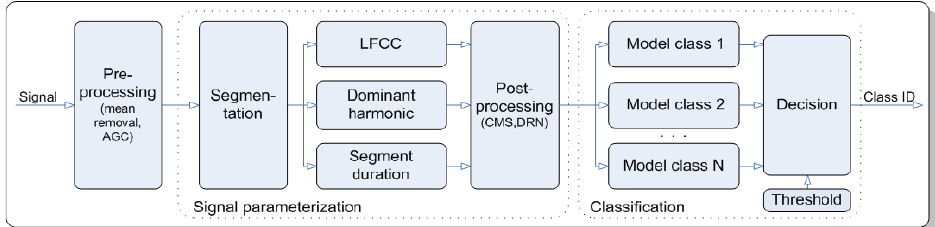
Figure 1. Diagram of the acoustic insect recognition process for N classes [5].